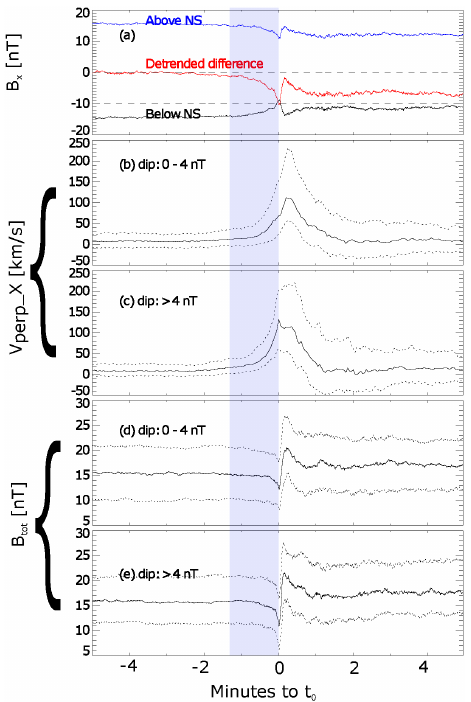
Figure 3. (a) The black curves show the superposed epoch analysis of magnetic field B x for DF events at both hemispheres; the red curve shows the difference in δB between both hemispheres, which were obtained by subtracting the average value between t 0 –4min to t 0 –3min from the statistical median. (b, c) The X -component of perpendicular bulk velocity for both DF